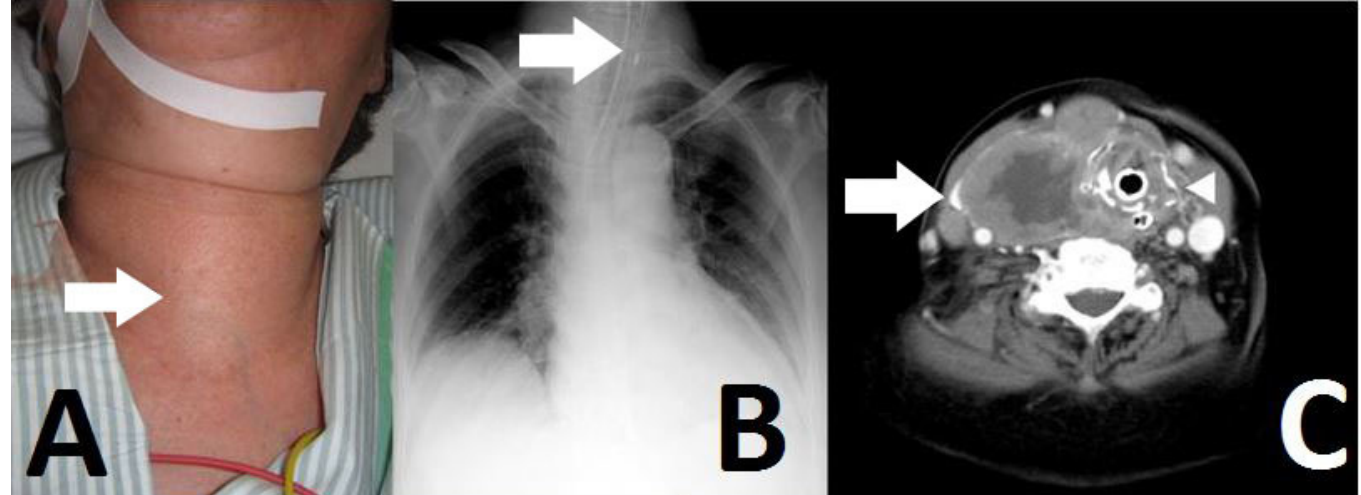
Figure 1. (A) Image showing swelling of the neck in our patient (arrow). (B) Chest radiograph after intubation showing a shift of the trachea to the left (arrow). (C) Contrast computed tomography image showing the thyroid tumor superior to the right lobe (arrow) and tumor invasion into the trachea at the height of the cricoid cartilage (arrow